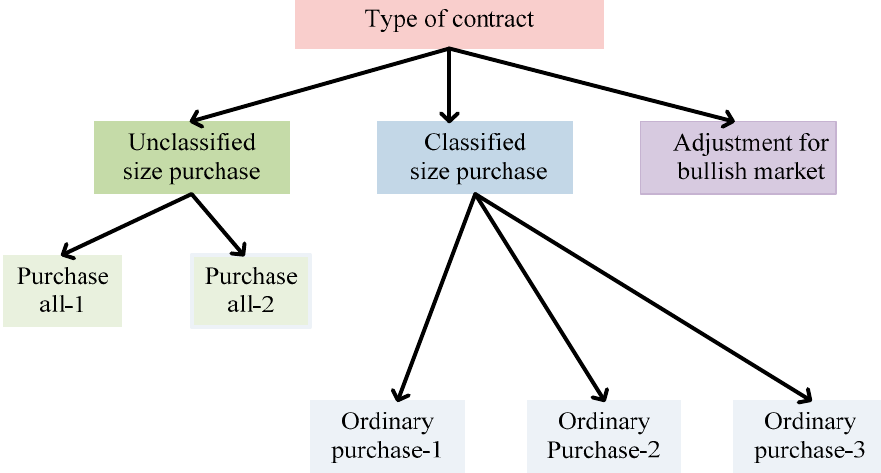
Figure 2. Selection of different types of designed contracts.